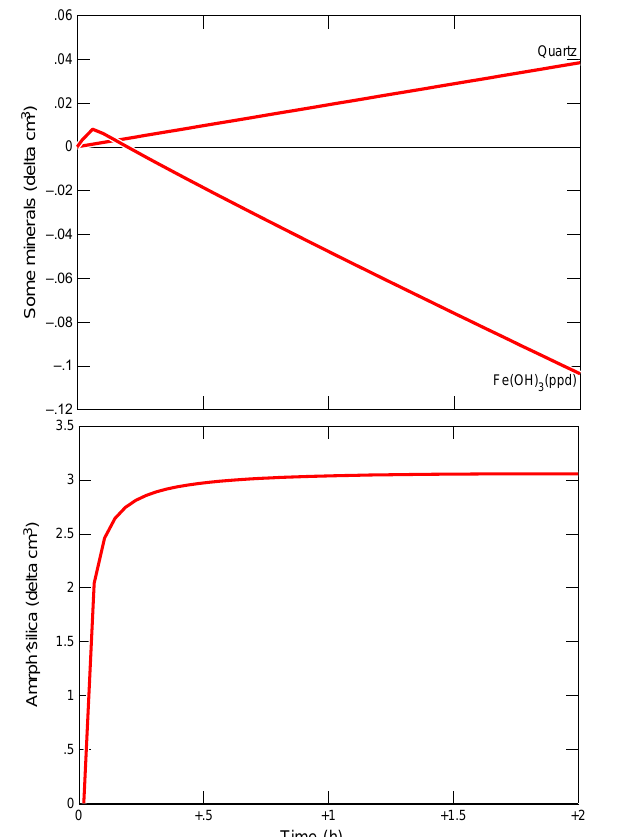
Figure 5. Recrystallization of quartz, decomposition of Fe(OH) 3 and precipitation of amorphous silica due to CO 2 injection – quartz sand aquifer. Compare the amounts to the model volume of 10000cm 3 .